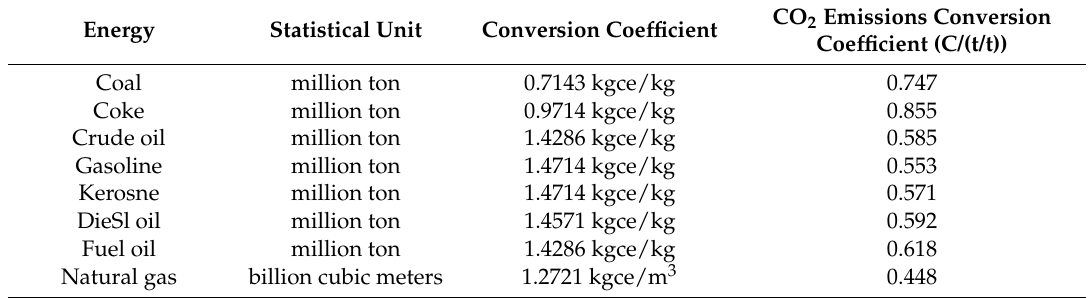
Table 2. Conversion coefficient and CO 2 emissions conversion coefficient of different kinds of